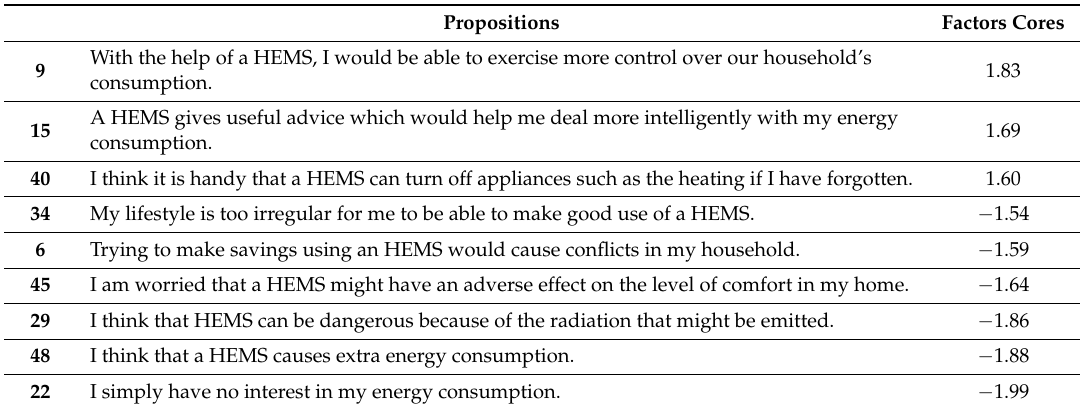
Table 4. Extreme factor scores of component 1 in unrotated